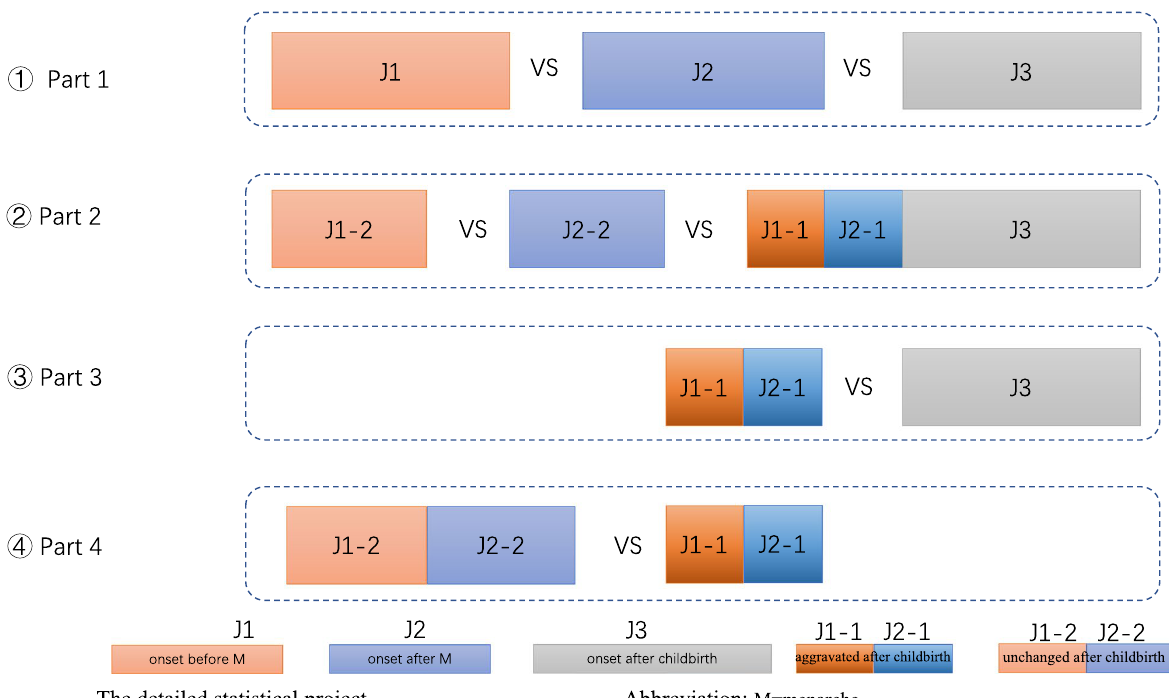
Fig. 3 The detailed statistical project of the study. The patients were divided according to the association of MWA onset with menarche and childbirth. Group J1: onset before menarche, group J2 onset after menarche but before childbirth, group J3 onset after childbirth. Patients who reported aggravation after childbirth in group J1 and group J2 were marked as J1-1 and J2-1, and those who reported no change were marked